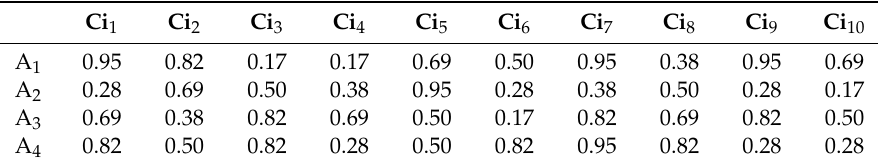
Table 24. Judgments matrix for alternatives relevant to criteria using the analytical hierarchy process